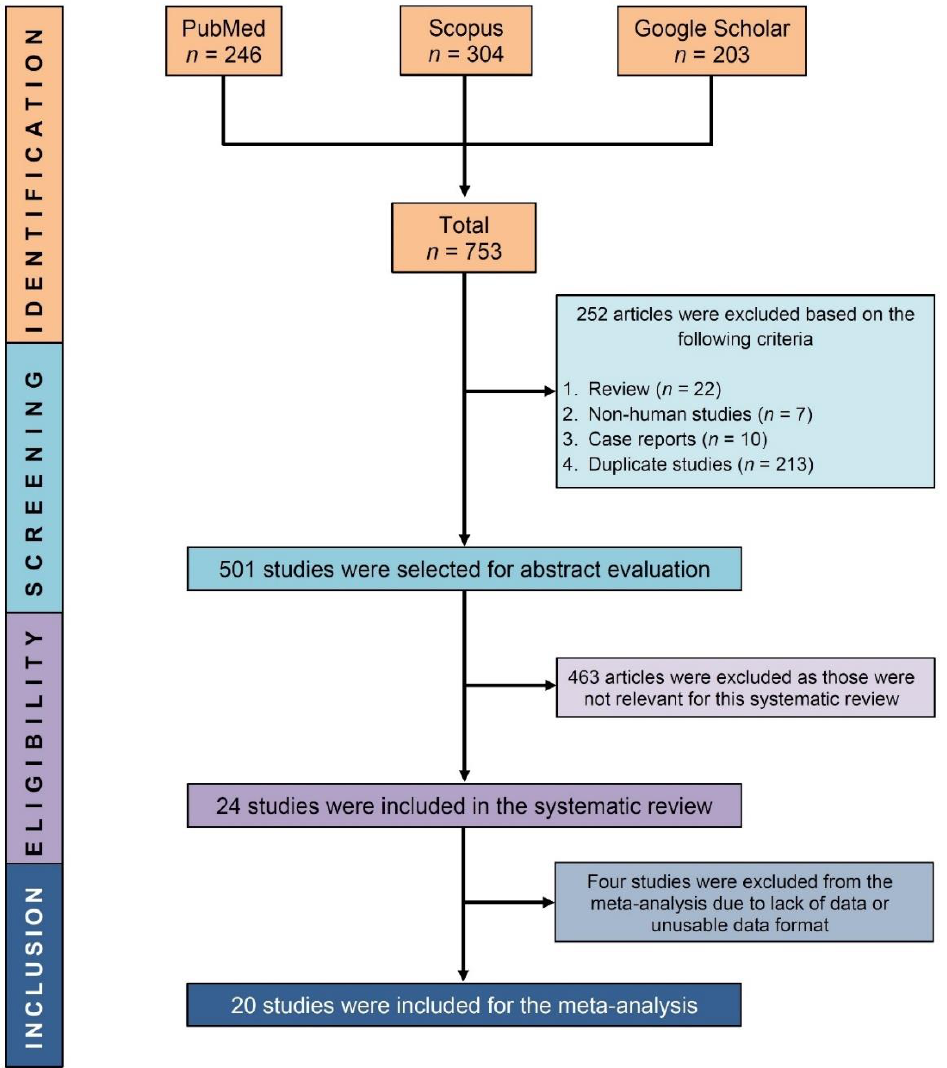
Figure 1. PRISMA flow diagram showing process of selecting eligible studies.